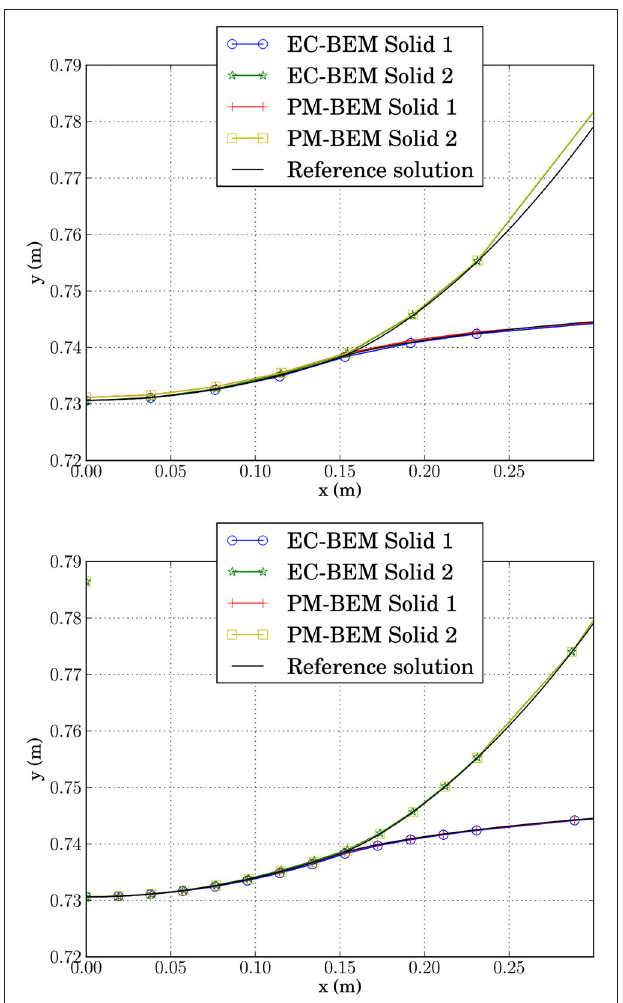
FIGURE 16 | Comparison of the deformed boundaries around the contact zone predicted by EC-BEM, for two different meshes (Mesh 1 and 2 of Table 6 in the top and bottom plot, respectively) with the Reference solution by PM-BEM (using Mesh 3 of Table 6 ).